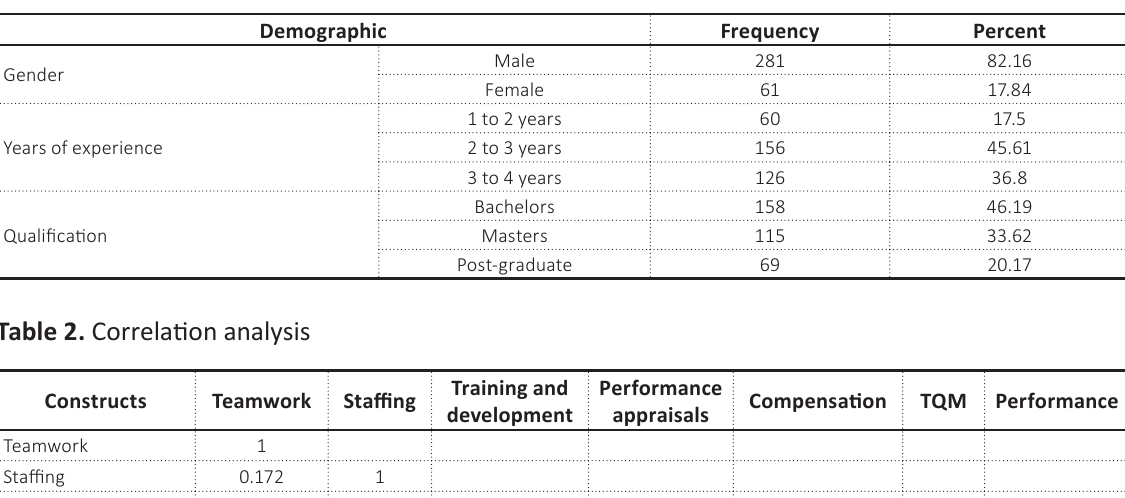
Table 1. Descriptive statistics ( n = 342)